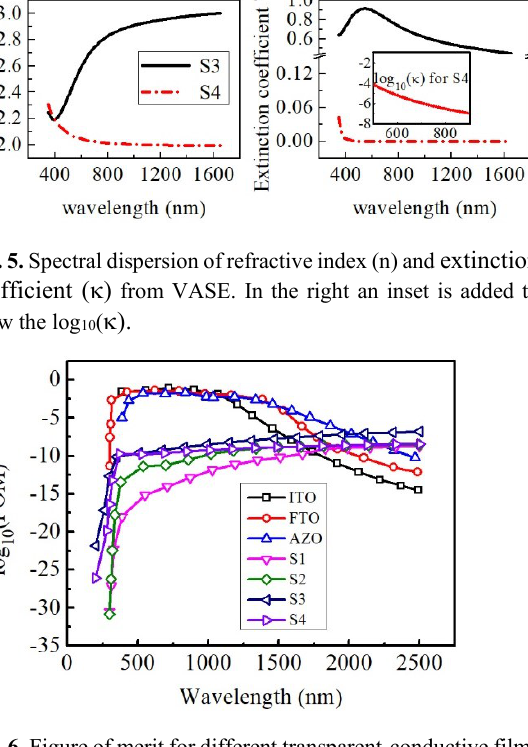
Fig. 6. Figure of merit for different transparent-conductive films, plotted by retrieving transmittance data and sheet resistance from: ITO [29], AZO [29], FTO